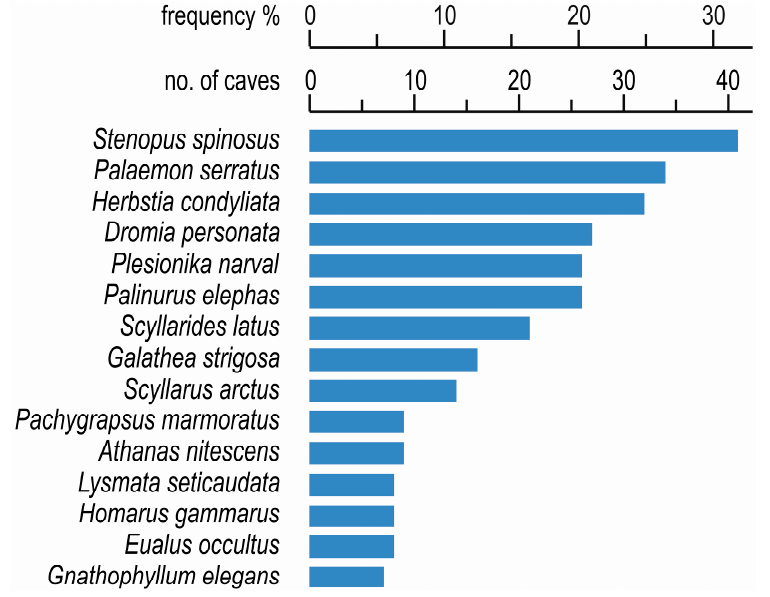
Figure 2. The 15 most common decapod species in Mediterranean Sea caves. Species found in less than seven caves (5%) are not considered.